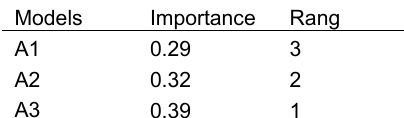
Figure 7 holds the results of the final decision.